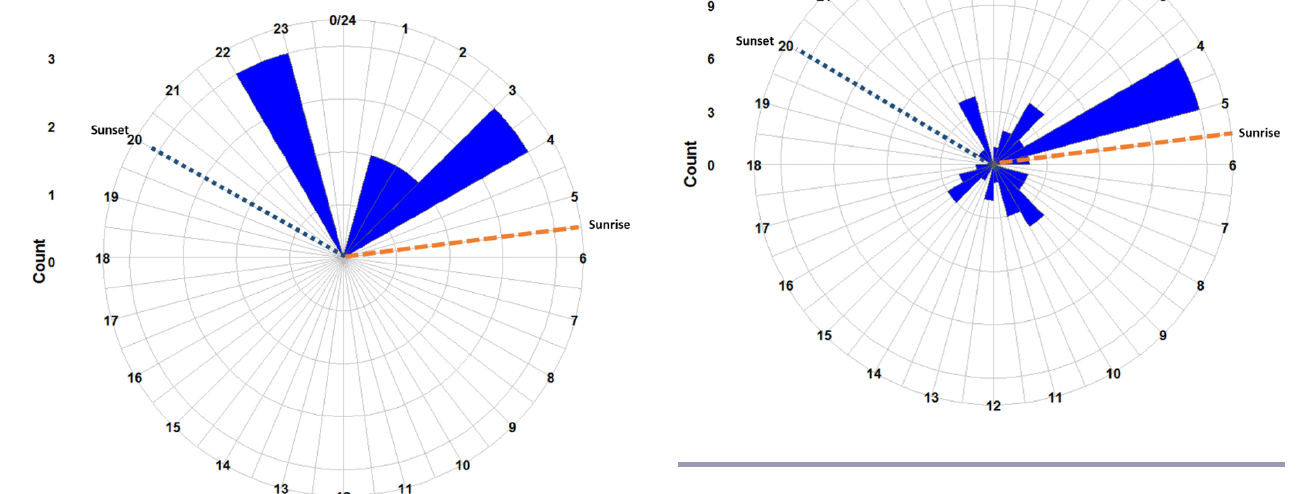
Fig. 5 . Diel variation (hrs, in local time) in passage times of Arctic Terns ( Sterna paradisaea ; n = 4) from Petit Manan Island, Maine, USA passing through sites in Nova Scotia, Canada during the postbreeding period in 2013. Dashed lines show local times of sunrise (orange) and sunset (blue).